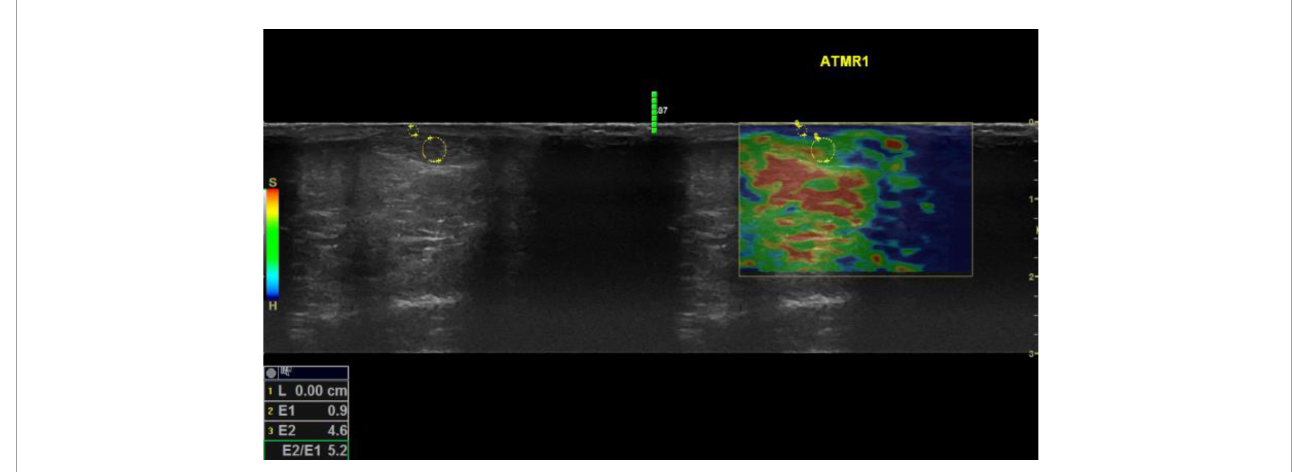
FIGURE1 Sonoelastography images of the mid Achilles tendon examined during rest for a participant with hypermobility spectrum disorder. Keys: Red refers to soft, green refers to medium, and blue refers to hard tissue. E2/E1 refers to the strain ratio; the higher the strain ratio, the higher the elasticity (41). Words in yellow are coding written by the operator for saving purposes. Four compressions were applied for each examination, and an image associated with the third compression was selected to attain the strain ratio. Using the colored SEG image, the position of the image box was moved to incorporate the AOI with an adjacent subcutaneous fat layer as a reference. A circle was traced to encompass the entire mid portion of the AOI, then another circle was traced to encompass an adjacent subcutaneous fat layer as a reference encoding blue color pixels. The size of the traced area as a reference has no influence on the strain ratio (42). The two areas were selected to be as adjacent as possible to ensure that they were subjected to the same magnitude of compressions. Musculoskeletal structures lack fat tissues; therefore, subcutaneous fat is the most applicable for musculoskeletal examination, which shows comparable reliability compared to using alternative areas (42).